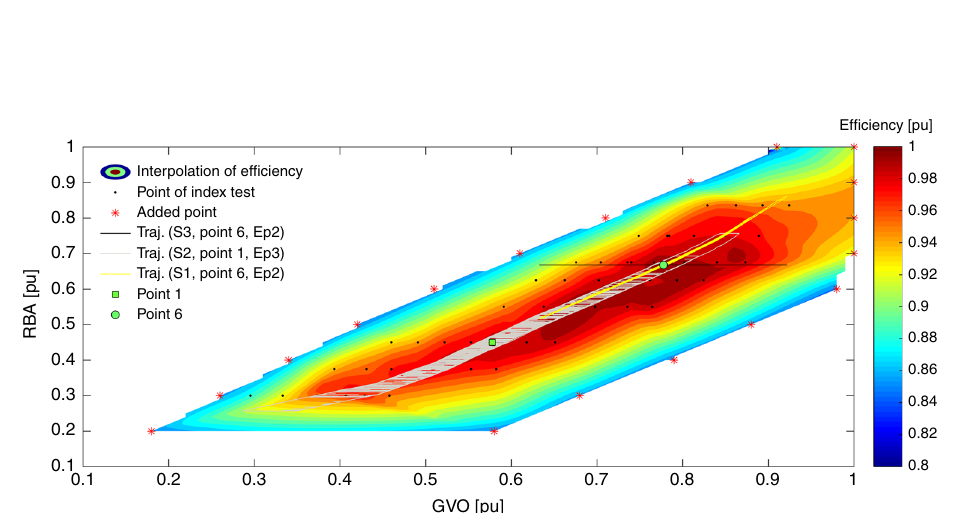
Fig. 3 Ef fi ciency contour of HPP 2 from interpolation of the ef fi ciency measurements and the operation trajectories during the 24 h. The trajectories are from operation strategies S1 – S3 with different operating points and governor parameters (Ep2 and Ep3). The ef fi ciency value is normalized with respect to the maximum ef fi ciency value. The black dots show the locations of the operating points in the index test, corresponding to the blue markers in Supplementary Fig. 7 and Supplementary Fig.